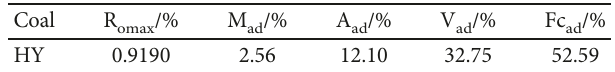
Table 1: Proximate analysis and maximum vitrinite re fl ectance of coal samples.